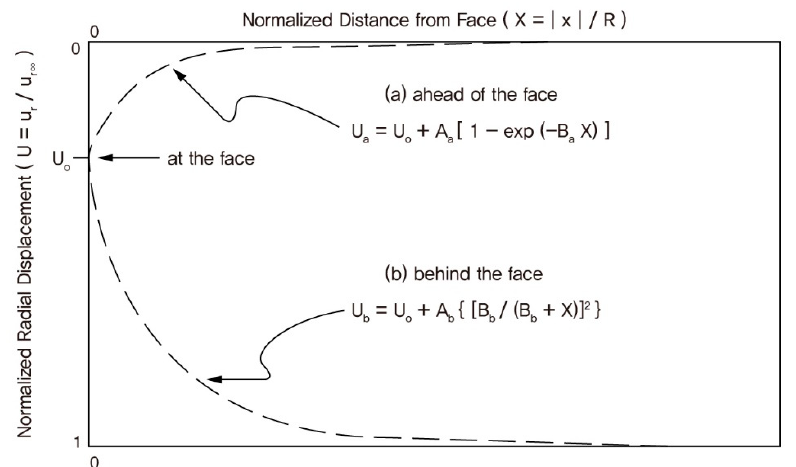
Figure 4. Statistical LDP models used for the normalized radial displacements occurring around the face [12].